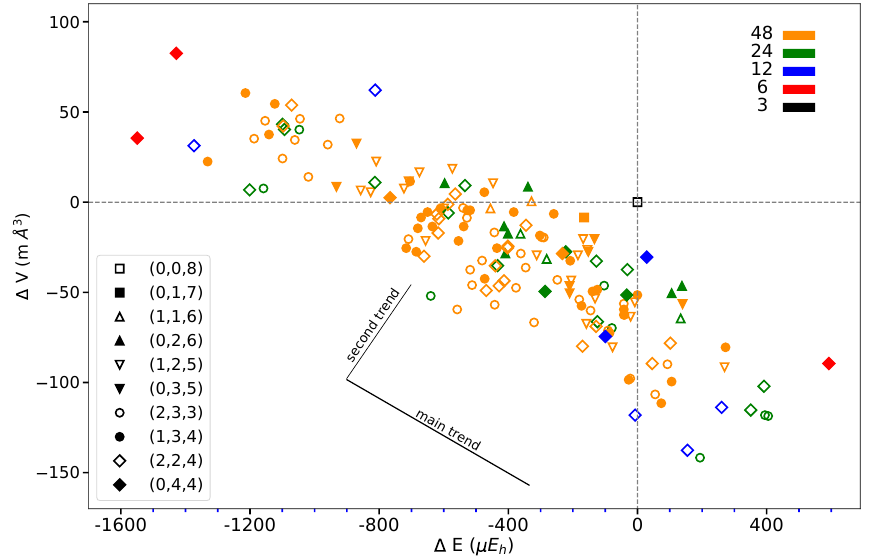
Figure 7. Volume difference versus energy difference with respect to REF or ( 0,0,8 ) as obtained for the 162 SICs of the S222 supercell of KFeF 3 . The figure legend associates symbols and CECs, color, and multiplicity, as in Figure 5. The two trends described in the text are sketched. Energy in E h and volume in Å 3 refer to two